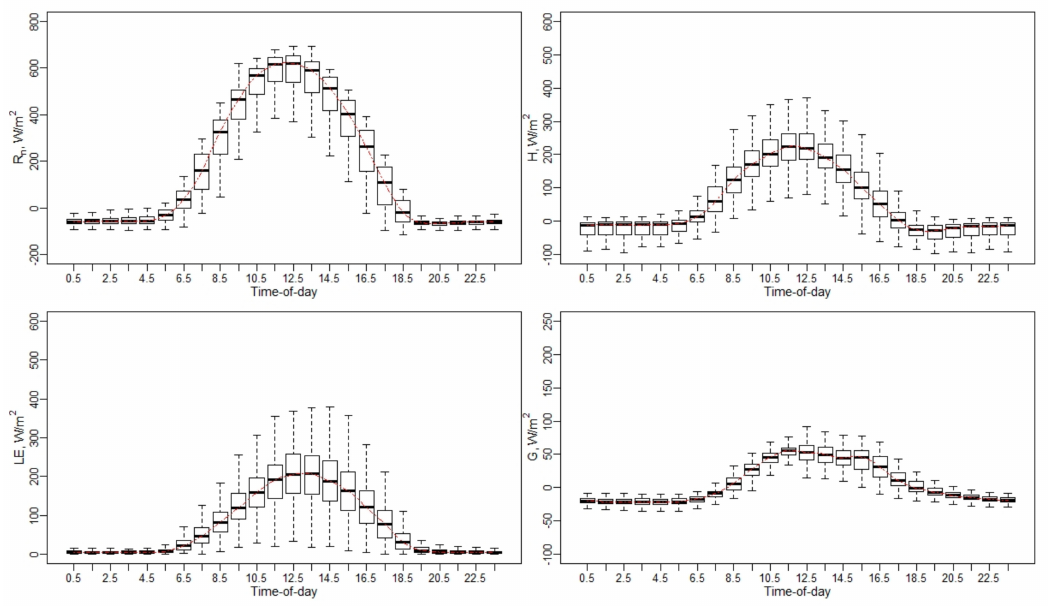
Figure A19. Diurnal variation of surface energy fluxes ( R n , H , LE , and G ).